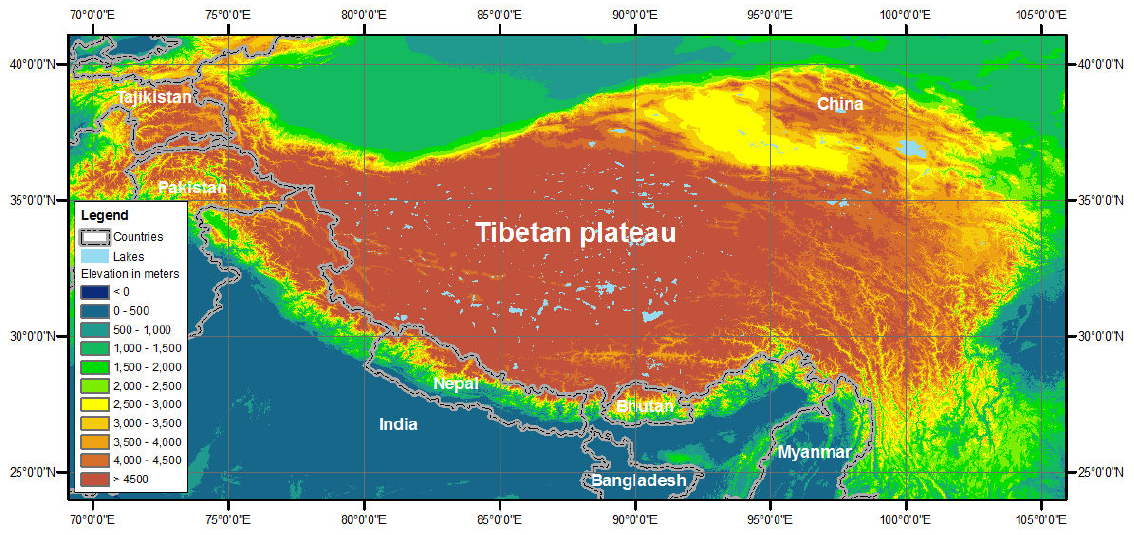
Figure 1. The Tibetan